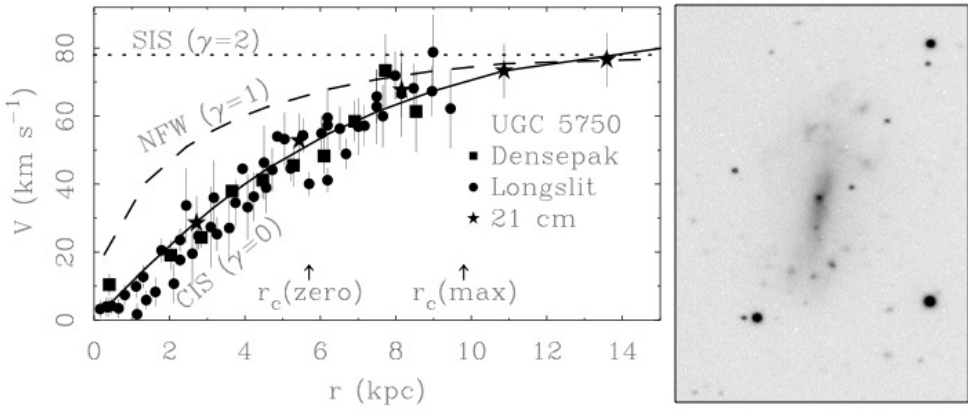
Figure 5. Rotation curve (left panel) of UGC 5750 (the LSB galaxy, showed in the right panel). The data of the rotation curve are obtained with the integrated field H α spectroscopy (squares) [197], long slit optical observations of the Balmer transition (circles) [193,198], and radio observations of the 21 cm atomic hydrogen spin flip transition (stars) [199]. The isothermal sphere with a core (CIS) profile (solid line) fits the data. r c ( zero ) and r c ( max ) are the values of the core radius obtained from the fit in the no disk and maximum-disk case, respectively; the solid line is the case of no disk. Neither the NFW profile (dashed line), whose parameters are fixed and given by the Λ CDM cosmology, nor the singular isothermal sphere (SIS) profile can describe the dark-matter halo of this LSB galaxy. The figure is reproduced from